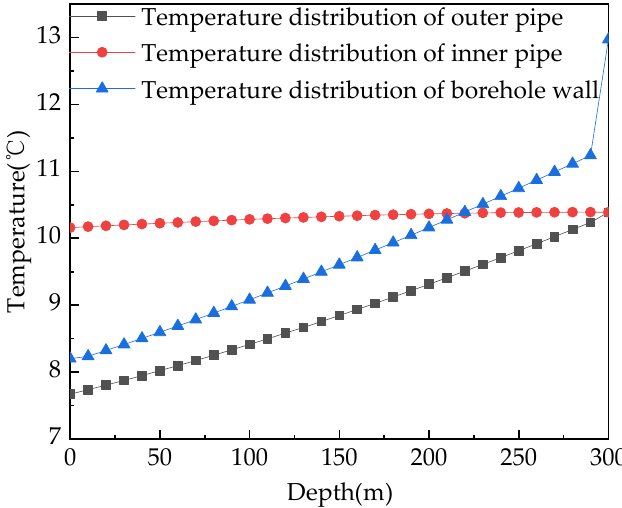
Figure 9. Temperature distribution in winter.